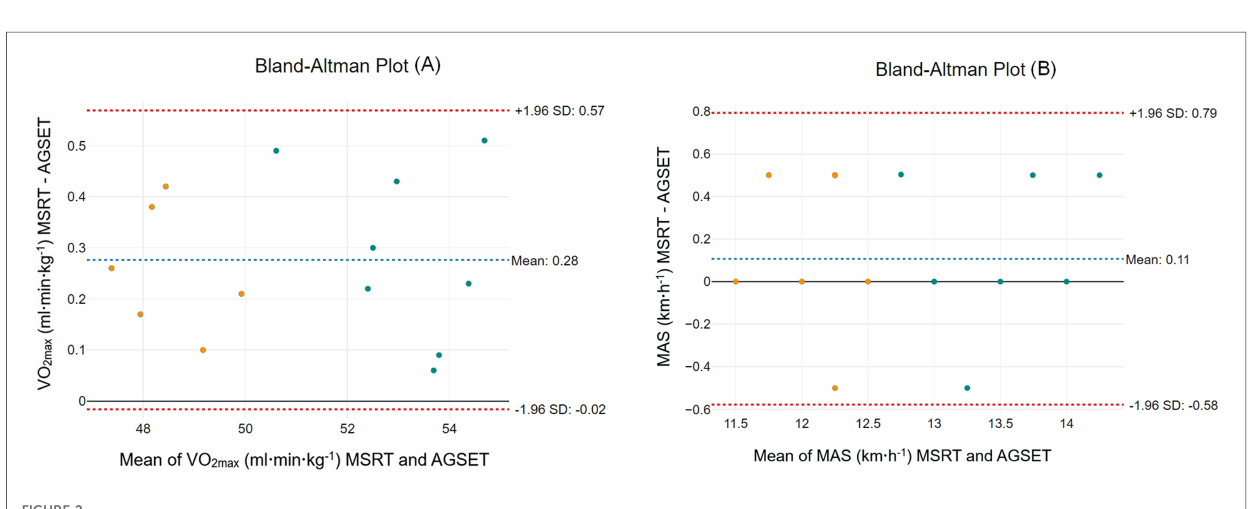
FIGURE 2 Bland and altman plots for maximal oxygen uptake ( A ) and maximal aerobic speed ( B ) derived from multistage shuttle run test and artistic gymnastics- speci fi c endurance